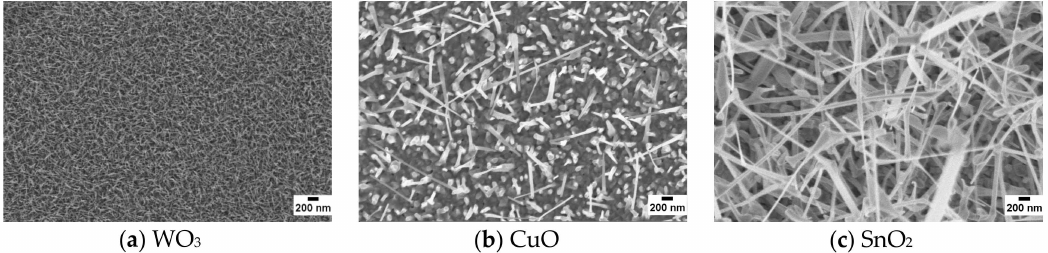
Figure 4. SEM pictures of WO 3 ( a ), CuO ( b ), and SnO 2 ( c ) nanowires directly synthesized on ams hotplates.